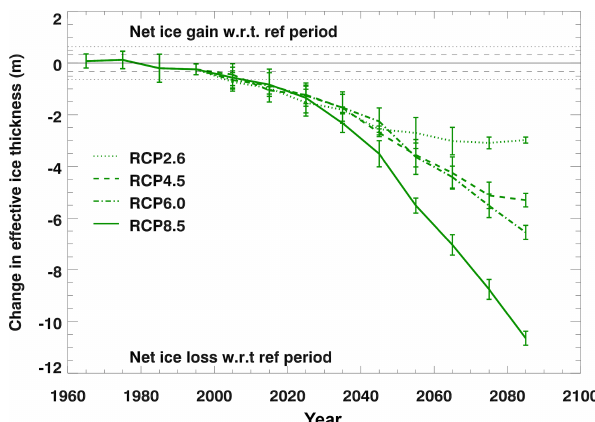
Figure 8. Decadal mean values of the basal growth component of the sea ice volume budget of HadGEM2-ES, plotted as differences relative to the reference period 1960–1989 for each of the forcing scenarios. Values are ensemble means ± 1 standard deviation, and positive values correspond to net ice gain with respect to the refer- ence period. The horizontal dashed and dotted lines show ± 1 and 2 standard deviations as calculated from 250 years of the HadGEM2- ES pre-industrial control integration.